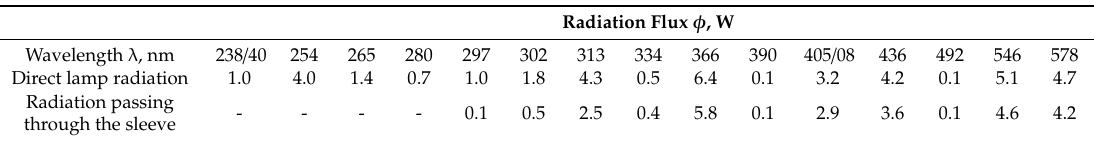
Table 4. Physicochemical characteristics of the studied CECs (Data achieved from the supplier of Heraeus UV lamp reactors KENDROLAB Sp. z o.o.).